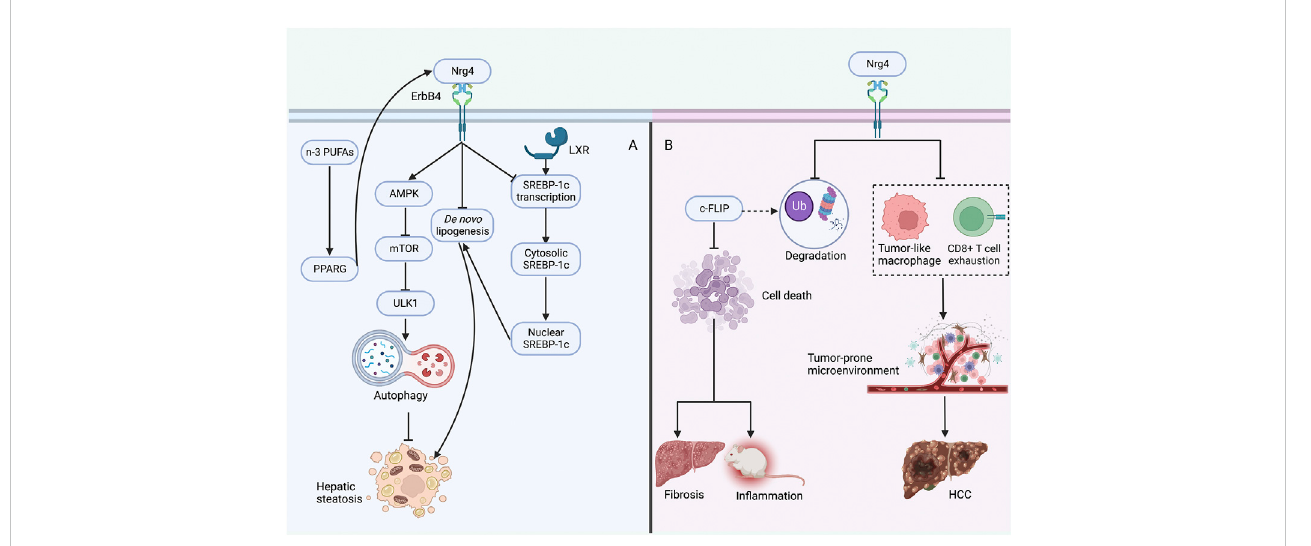
FIGURE 4 Protective role of Nrg4 in hepatic steatosis and NASH (A) Nrg4 speci fi cally binds to the hepatic ErbB4 receptor, increases autophagy through the AMPK/ mTOR pathway to improve steatosis, and can also reduce lipogenesis by decreasing the expression of genes involved in de novo adipogenesis. Nrg4 can reduce lipogenesis by inhibiting the expression of SREBP-1c. Supplementation of n-3 PUFAs may improve NAFLD by increasing Nrg4 expression through PPARG. (B) Nrg4reducesubiquitinationandproteasomaldegradationofc-FLIPtoregulateitsexpression,whichcanreduce fi brosisandin fl ammationby reducing hepatocyte death. Alternatively, Nrg4 may prevent HCC development by alleviating the tumor-prone microenvironment in NASH. Abbreviations: Nrg4, neuregulin four; NASH, non-alcoholic steatohepatitis; AMPK, adenosine monophosphate-activated protein kinase; mTOR, mechanistic target of rapamycin; SREBP-1c, sterol regulatory element binding protein-1c; ULK1, unc-51-like kinase one; LXR, liver-X receptor; PPARG, peroxisome proliferator- activated receptor gamma; n-3 PUFAs, n-3 polyunsaturated fatty acids; c-FLIP, cellular FADD-like IL-1 β -converting enzyme-inhibitory protein; HCC, hepatocellular